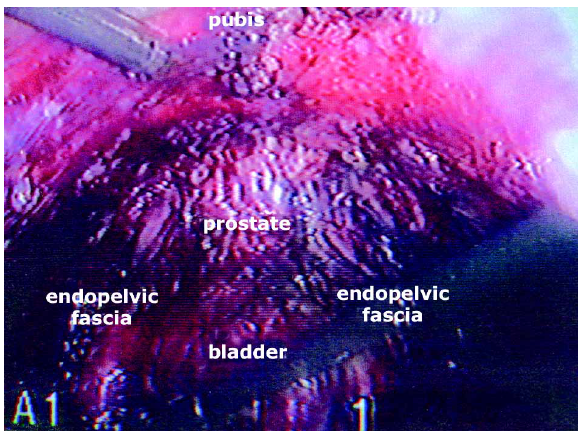
Figure 8 – Anatomic repairs in pelvic access (endoscopic view). Visualization of bladder, prostate and pubic